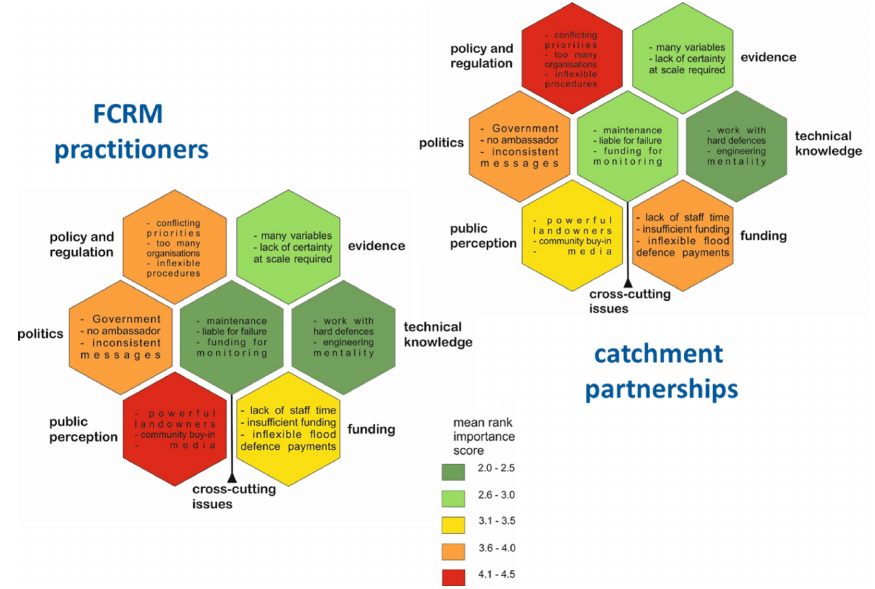
Figure 6. The revised concept maps following phase-3 participant interpretation and analysis. Table 2. Barrier statements from the group concept mapping method showing large differences in perception between practitioner groups.